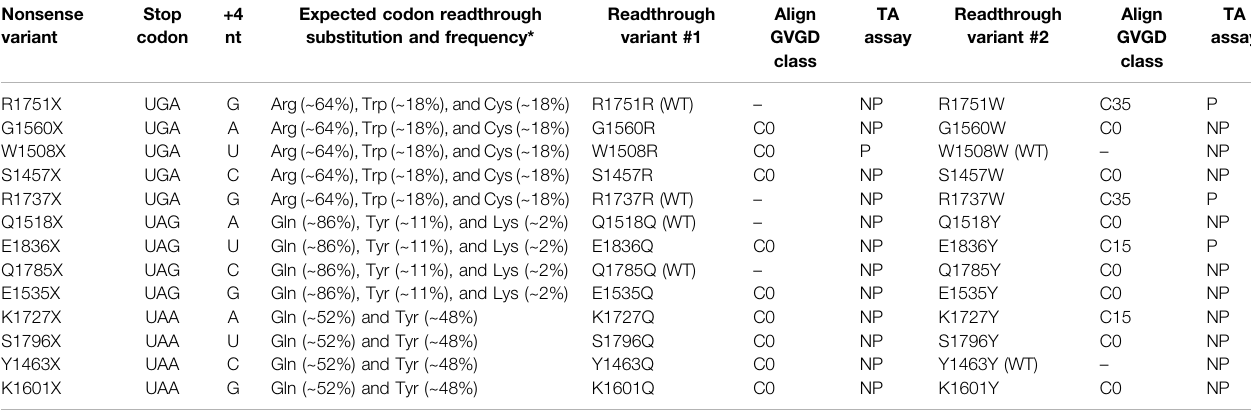
TABLE 1 | Predicted readthrough variants - analyses